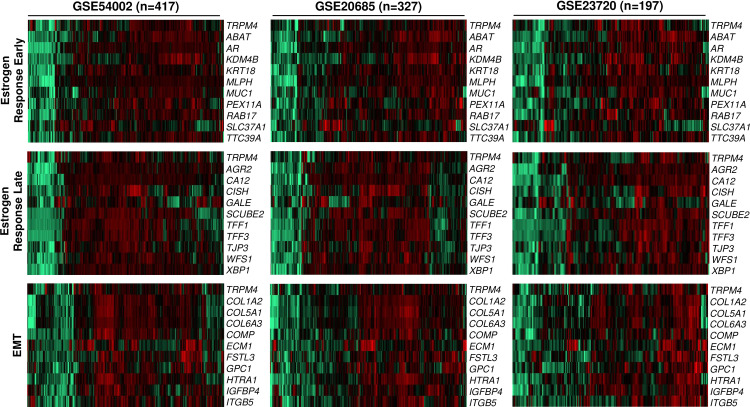
Heat map of TRPM4 and top representative genes (n = 10 in each gene set and GEP dataset) contributing to the core enrichment of each gene set.